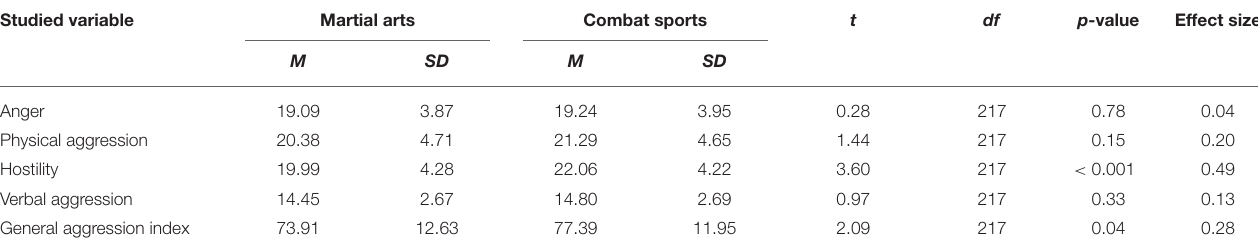
TABLE 3 | Comparison of the level of aggression dimensions between martial arts and combat sports athletes. Studied